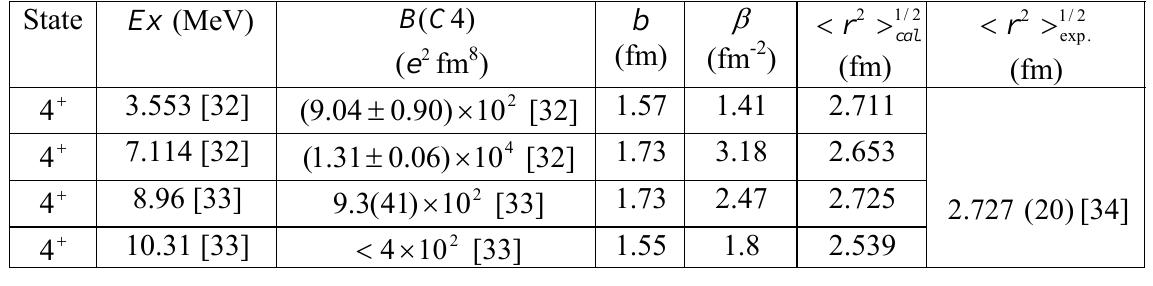
Table 1: The experimental excitation energies and reduced transition probabilities, the chosen values for b and  as well as the rms charge radius calculated with the effect of the SRC of 18